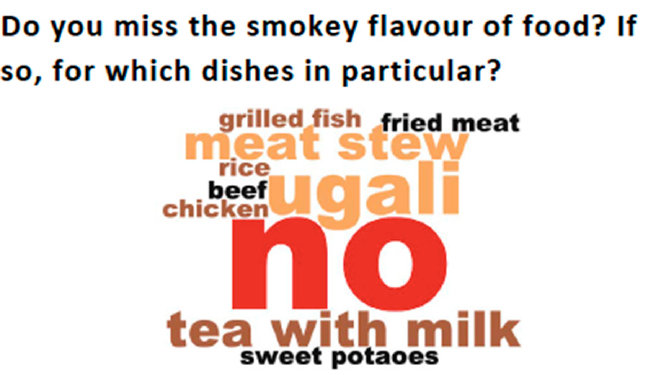
Figure 1. Word cloud summarising opinions of cooking diary participants in Kenya after testing eCooking appliances at home for a month eCooking appliances at home for a month [19].